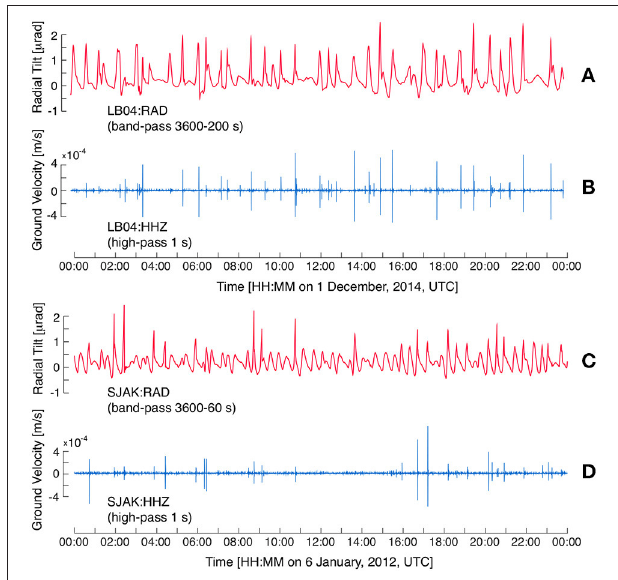
FIGURE 6 | Radial tilt (red) derived from ground velocity (blue) recorded from seismometers or tiltmeters located close to El Caliente vent during two studies: LB04 (A,B) from our study, and SJAK (C,D) from Johnson et al. (2014). Station SJAK was deployed in the approximately the same location as station